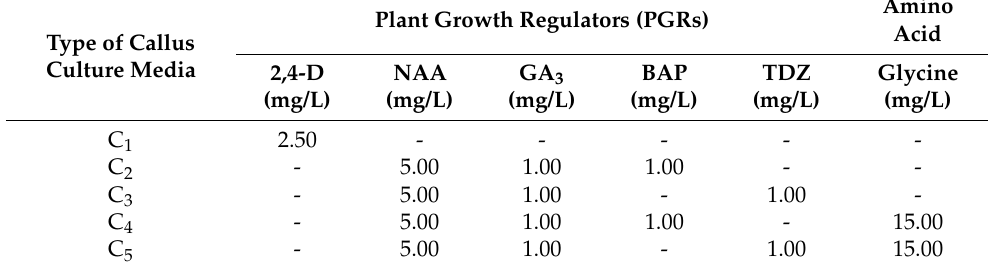
Table 4. MS culture media composition for PFP callus initiation and subcultivation. Sucrose was added at 20 g/L, Gelrite at 3 g/L, and the pH value was 5.7 before autoclaving for all tested culture